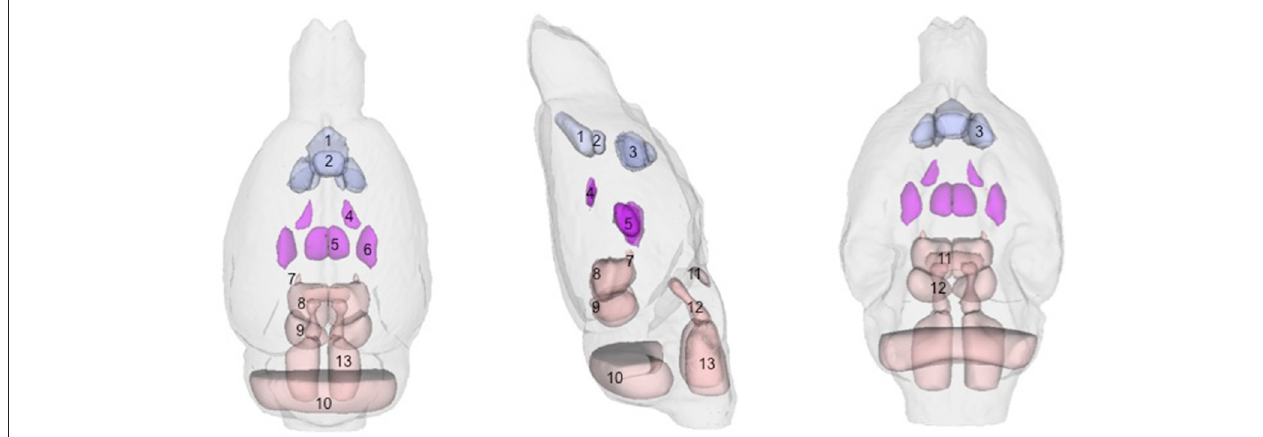
FIGURE 1 | Regions-of-interest (ROIs) identified via the Paxinos-Watson (PW) digital atlas to show at least 10% volume change between groups over the course of the experiment (refer to Table 1 ): (1) infralimbic cortex, (2) prelimbic cortex, (3) nucleus accumbens (core and shell), (4) lateral ventricles, (5) central thalamus, (6) VPL/VPM (ventral posterior lateral and medial) thalamus, (7) anterior pretectal nuclei, (8) superior colliculus, (9) inferior colliculus. Also labeled, (10) cerebellum, (11) pontine nuclei, (12) pontine reticular nuclei, (13) reticular nuclei of the pons. ROIs in purple indicate reversible effects of EtOH exposure and recovery; ROIs in pink indicate enduring shrinkage; ROIs in light blue indicate enduring